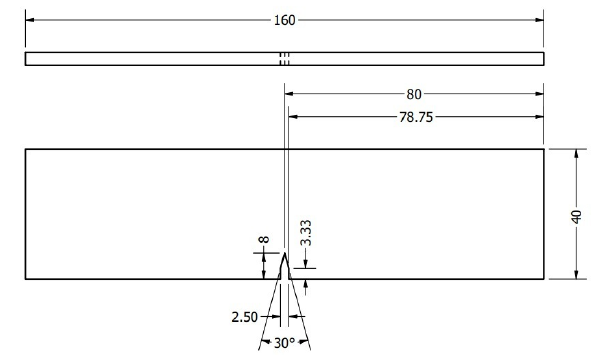
Figure 3: Dimension of fatigue crack growth rate specimen (mm).